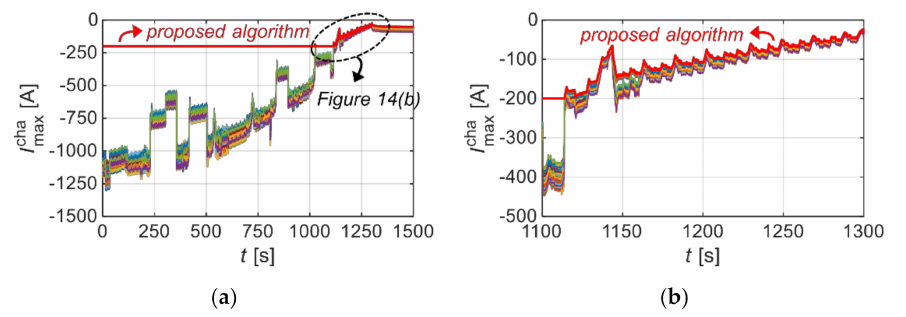
Figure 14. Comparison results of I cha max between each cell and the proposed algorithm: ( a ) at the time interval from 0–1500.0 s and ( b ) the enlarged waveform from 1100.0-1300.0 s.